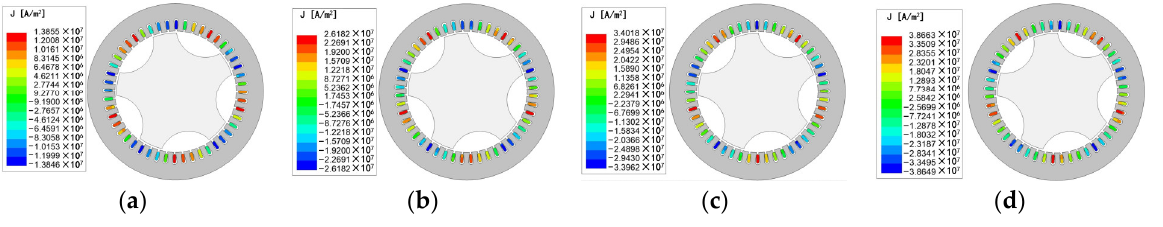
Figure 16. Current density distribution under different slip speeds and an excitation current of 6A. ( a ) Slip speed = 40 r/min; ( b ) slip speed = 80 r/min; ( c ) slip speed = 120 r/min; ( d ) slip speed = 160 r/min.